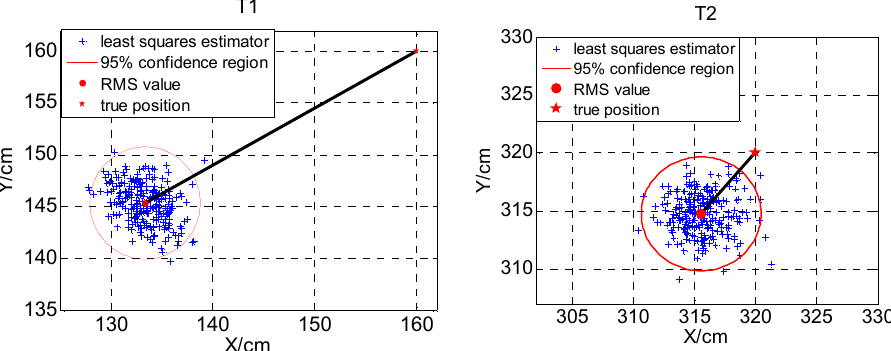
Figure 11. The location estimation results.